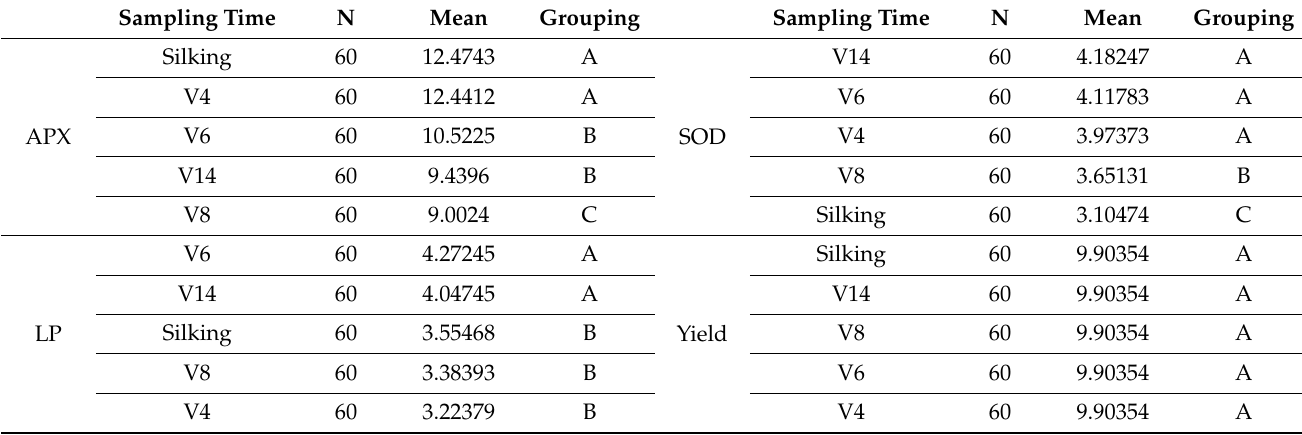
Table 5. Tukey grouping based on the applied nitrogen